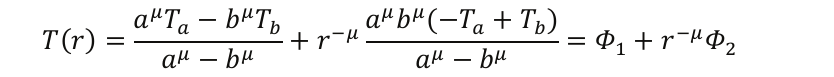
where k ( r ) is the non-uniform thermal conduction coefficient. Yildirim (2017b) solved the above equation under steady-state Dirichlet’s boundary conditions, T ( a ) = T